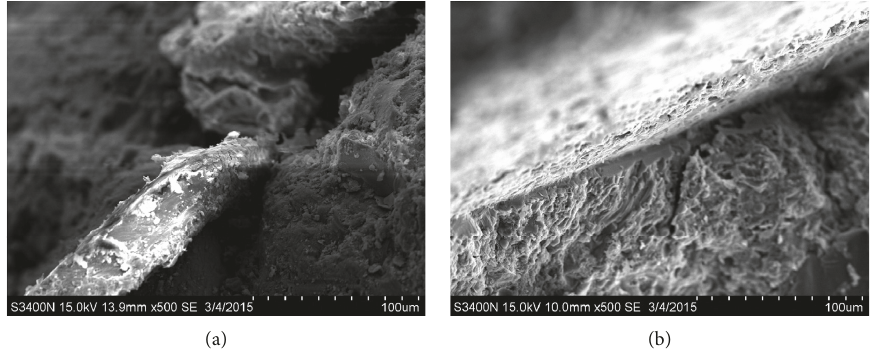
Figure 7: SEM patterns of SFRC (a) and AAFRC (b) at 28